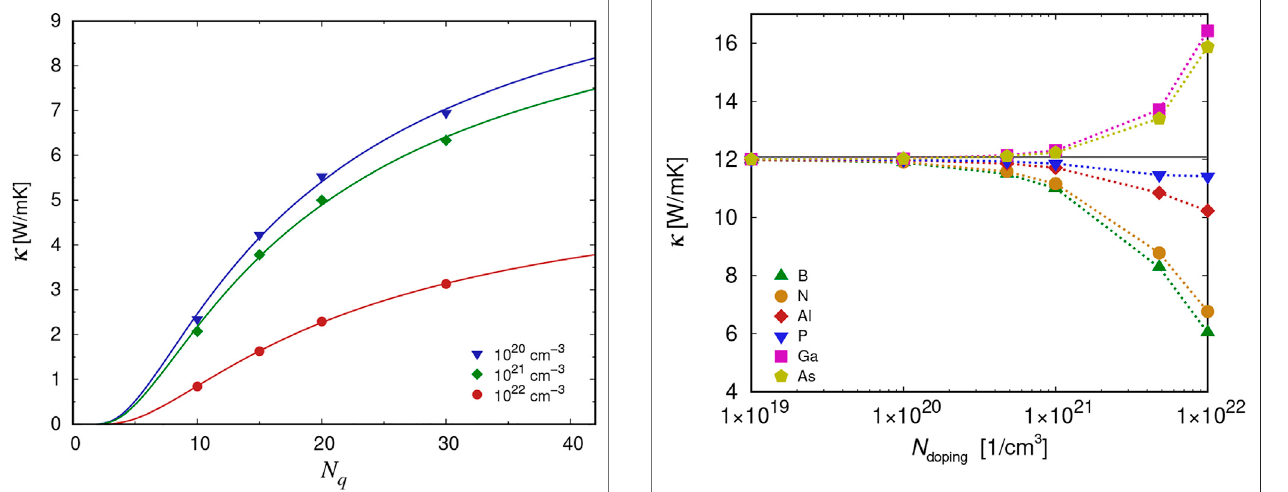
FIGURE 1 | Thermal conductivity in B-doped Si 0.5 Ge 0.5 as a function of the integration grid for different concentrations of B. Solid lines represent the (cid:19) that has been used to obtain the exponential function κ (cid:2) κ ∞ exp (cid:18) − a 1 N q thermal conductivity κ ∞ at an in fi nite integration grid.